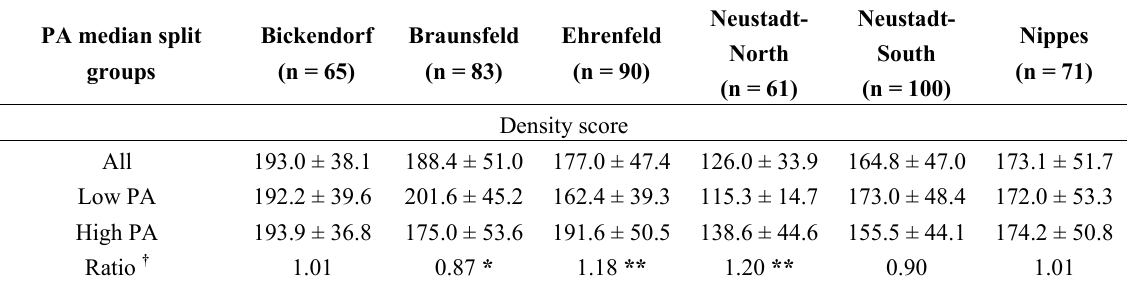
Table 5. Results of independent t-test for transport and recreation PA differences (city district-specific median split) in the perception of the themes of the neighbourhood environment (mean ± standard